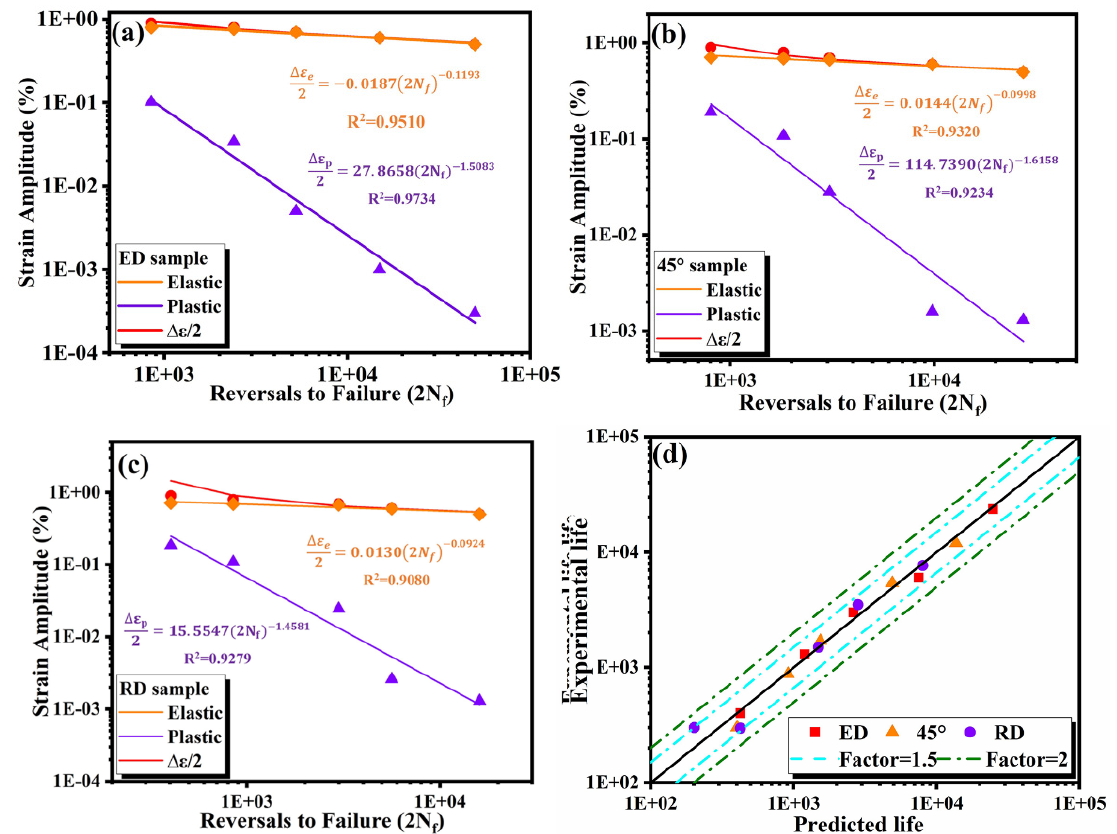
Figure 13. SWT prediction model for ( a ) ED ( b ) 45°( c )RD ( d ) SWT predicted vs. experimental life.